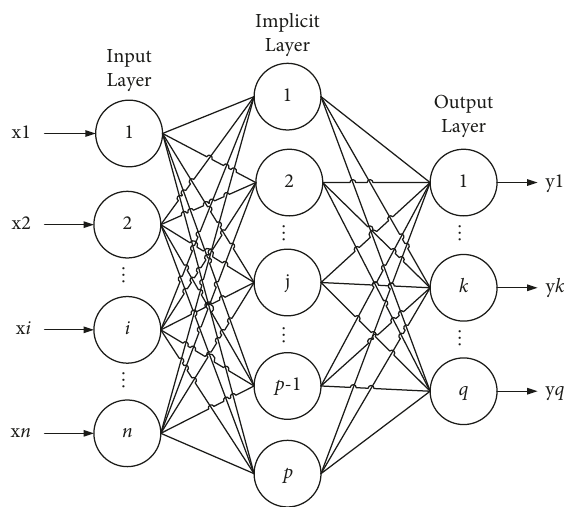
Figure 2: Topological structure diagram of the BP neural network model.